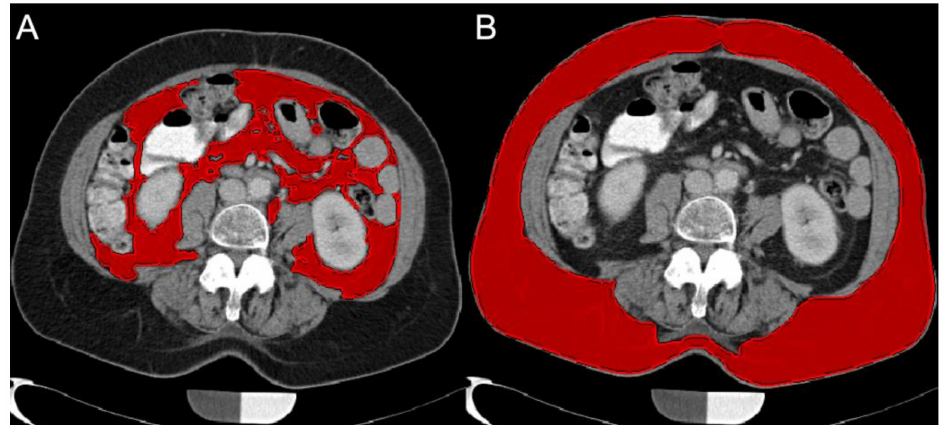
Figure 2. Representative segmentation for visceral adipose tissue (VAT; ( A )) and subcutaneous adipose tissue (SAT; ( B )) is shown at the level of